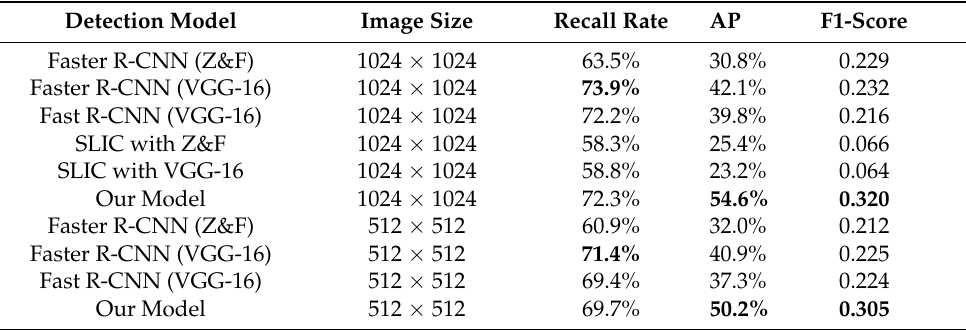
Table 2. Comparison results of various detection models on